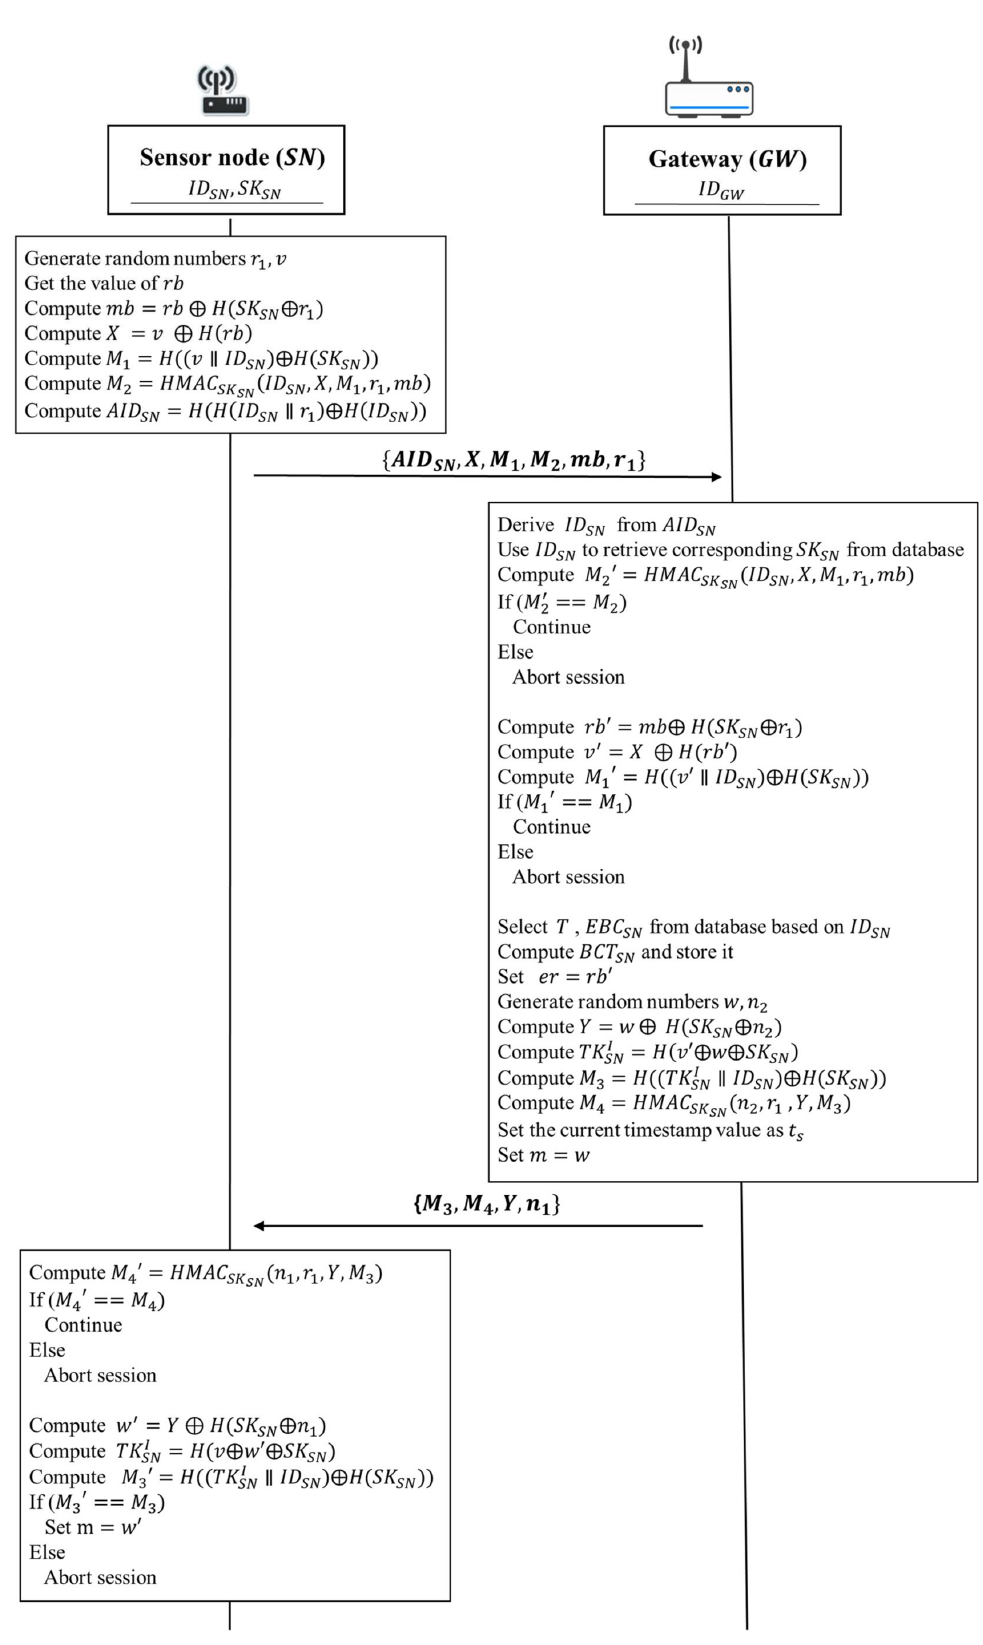
Figure 13. The static authentication phase with identity